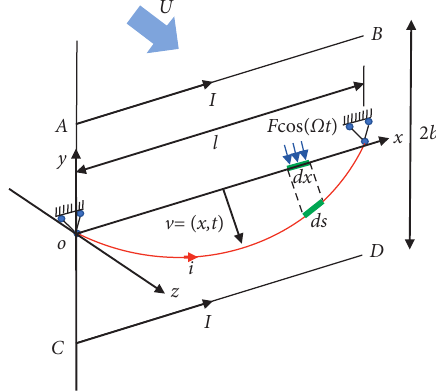
Figure 1: The model of current-carrying